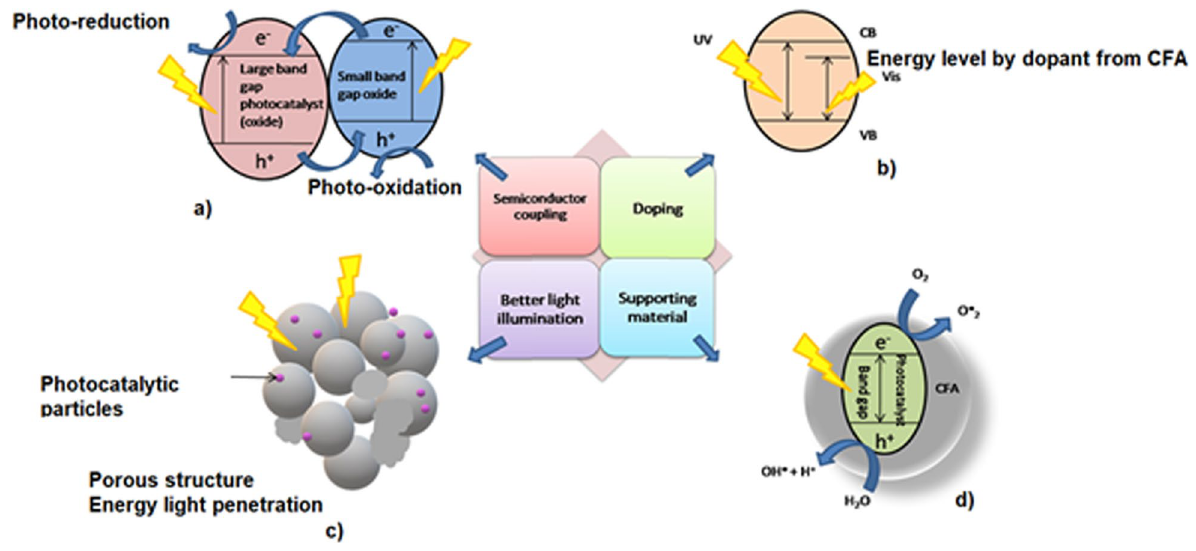
Fig. 15 Photocatalytic performance up-gradation by CFA through different strategies ( a ) Coupling of CFA constituent oxides with themselves or with externally introduced photocatalyst ( b ) Dop-